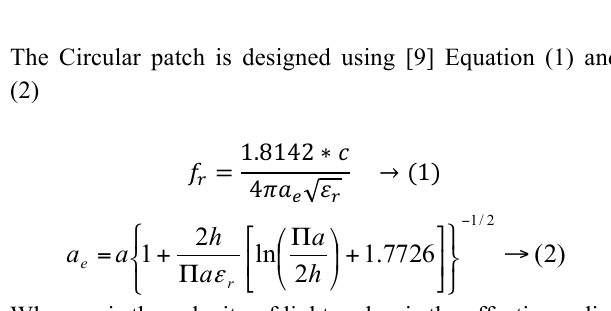
Figure 2: Proposed antenna